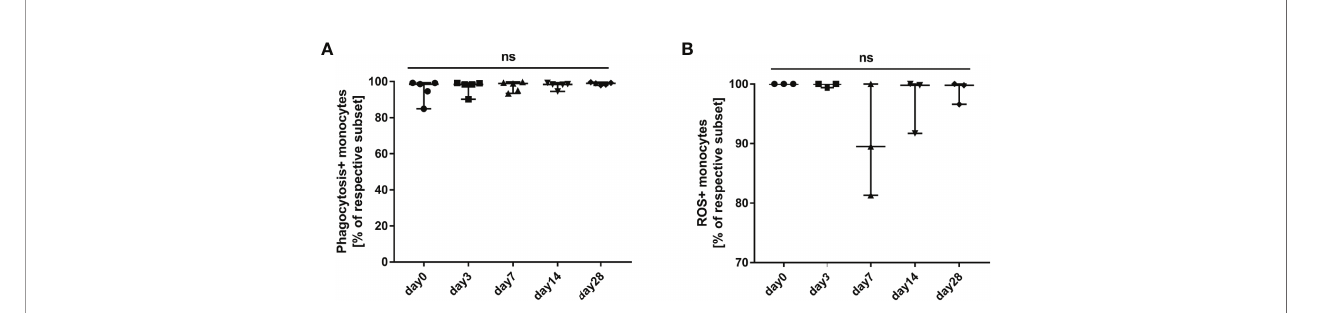
FIGURE 7 | In fl uence of G-CSF on phagocytosis and oxidative burst function of monocytes in HBV-ACLF. (A) Effect of G-CSF on phagocytosis function of monocytes (n=5). (B) Effect of G-CSF on oxidative burst function of monocytes (n=3). ns represents P > 0.05; G-CSF, Granulocyte-colony stimulating factor; HBV- ACLF, hepatitis B virus-related acute-on -chronic liver failure.